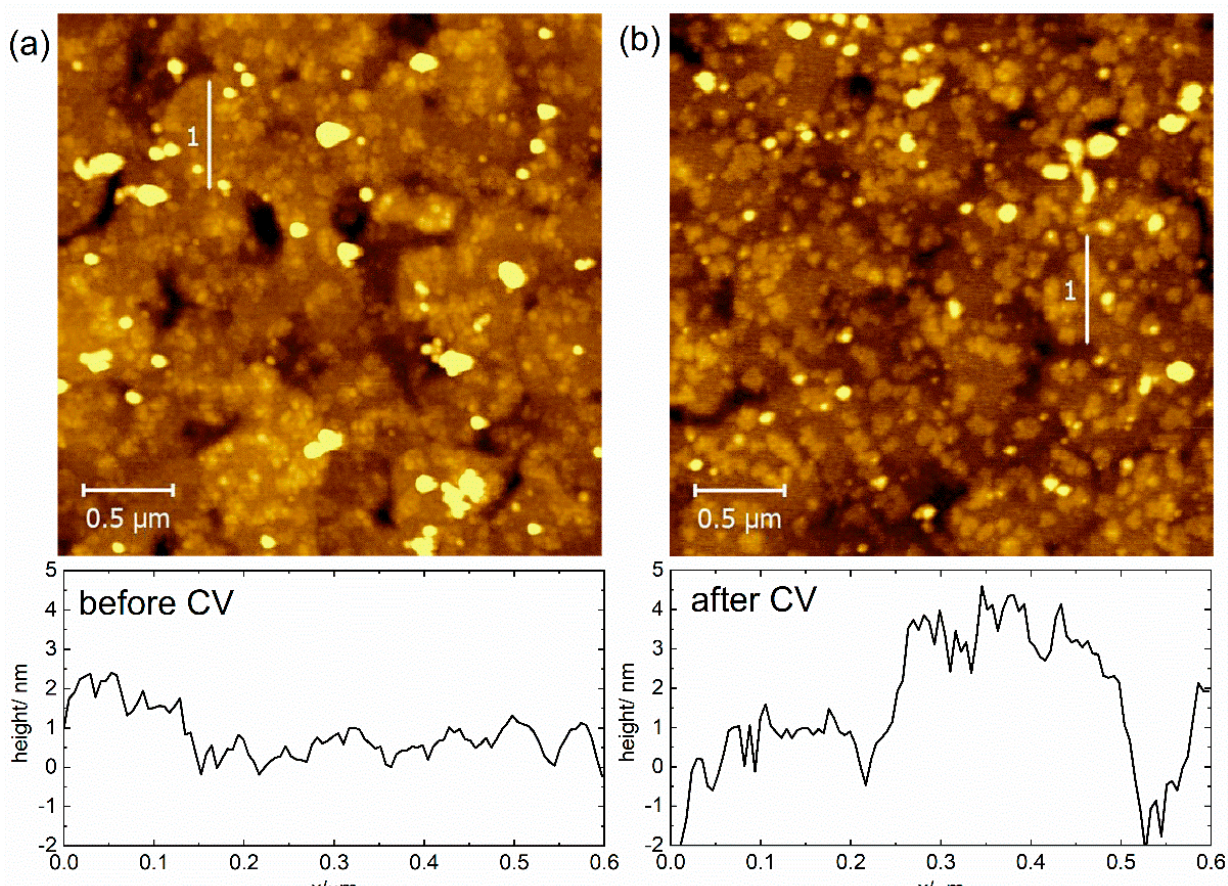
Figure 4. AFM topography image of 3 × 3 μ m 2 and graph of height profile along line 1 (upwards) for Os-tripod SAM on Au(111): ( a ) before; ( b ) after cyclic voltammetry experiment in 0.1 M TBAPF 6 in acetonitrile at scan rate 0.1 V s − 1 .